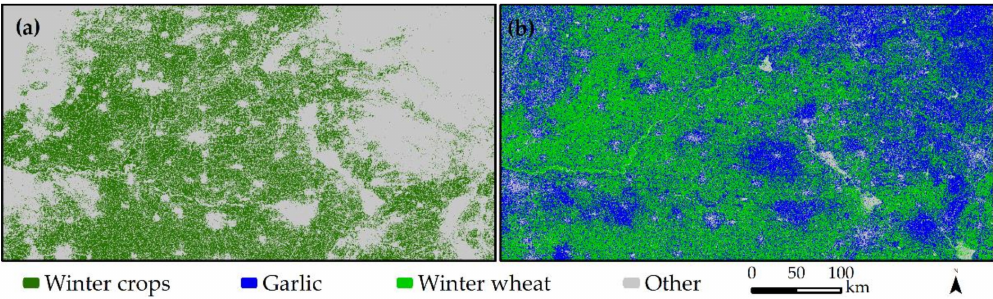
Figure 5. ( a ) Winter crops map (WCM) derived from optical composition images; ( b ) garlic and winter wheat classification results (GWC) derived from Sentinel-1 synthetic aperture radar (SAR) imagery.